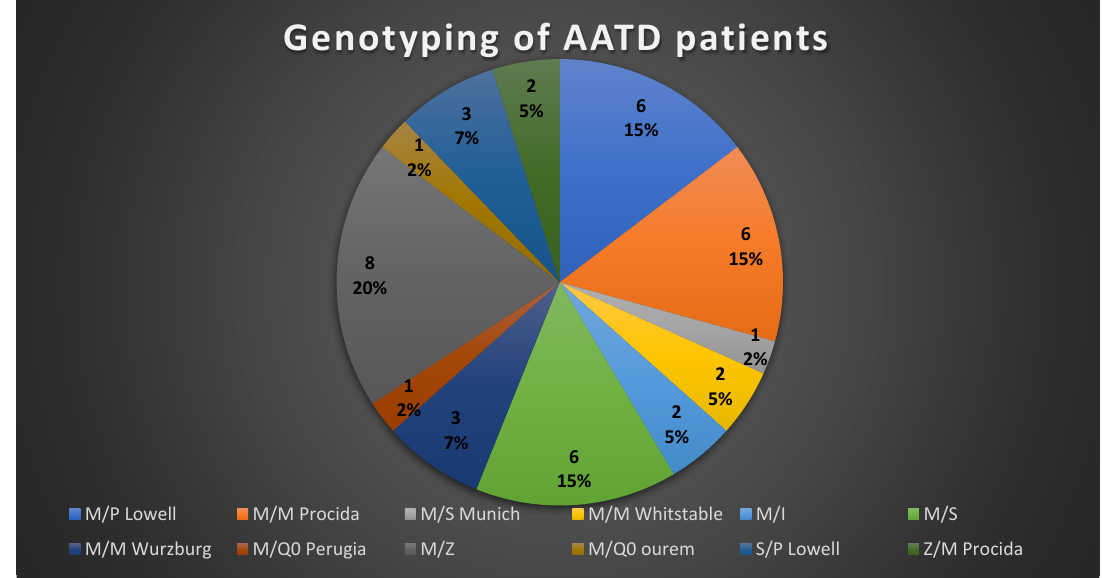
Figure 1. Genotyping of alpha-1 antitrypsin deficiency (AATD) patients. Samples from 41 patients with intermediate or low levels of AAT were subjected to genotyping, and the mutations identified are shown in this table.